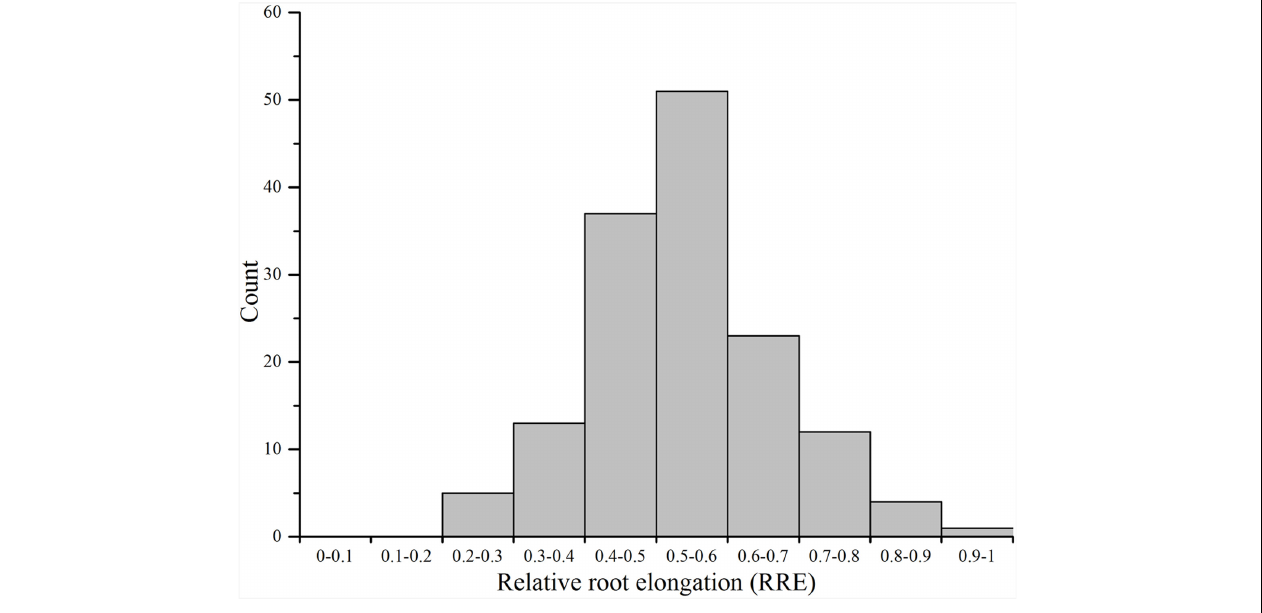
FIGURE 2 | Distribution of aluminum tolerance in the Ting’s core collection. TABLE 1 | Distribution of aluminum tolerance in the entire collection, subgroups, and sub-subgroups identified by STRUCTURE.